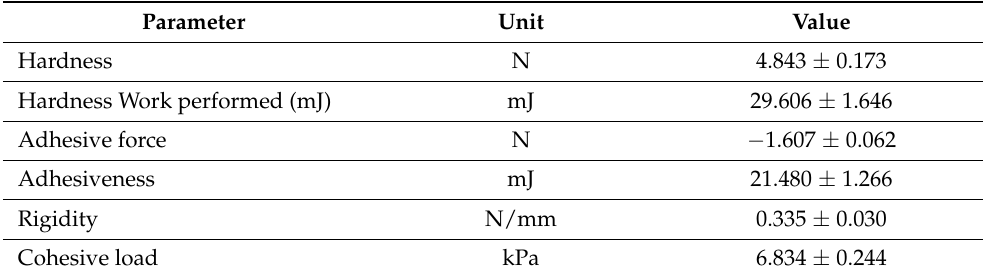
Table 4. Textural properties of hydroxide